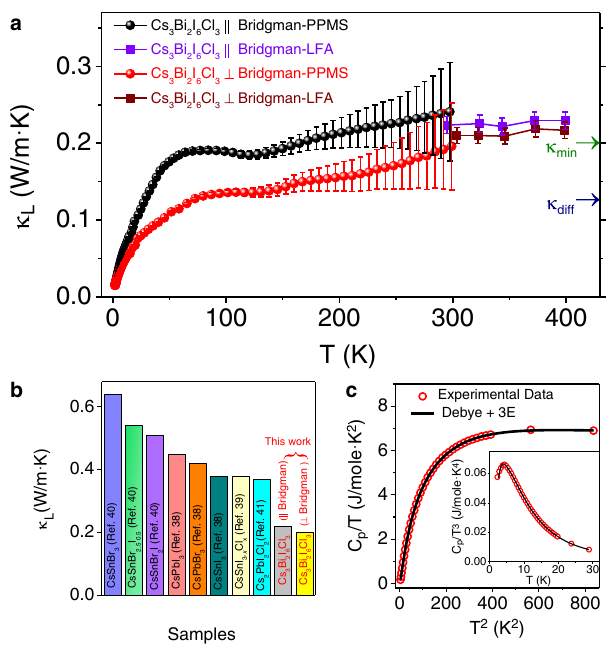
Fig. 2 | Glass-likethermalconductivityinCs 3 Bi 2 I 6 Cl 3 . a Temperature-dependent lattice thermal conductivity ( κ L ) of Cs 3 Bi 2 I 6 Cl 3 along parallel (||) and perpendicular ( ⊥ ) to the Bridgman growth directions measured using PPMS (2 – 300K) and LFA (300 – 400K). κ min is theoretical minimum value of κ L and κ diff is diffusive thermal conductivity. b Comparison of room temperature κ L of Cs 3 Bi 2 I 6 Cl 3 single crystal with other low thermal conductive all-inorganic halide perovskites 38 – 41 . c Low- temperatureC p /Tvs. T 2 plot of Cs 3 Bi 2 I 6 Cl 3 and fi t with Debye-Einsteinmodel.Inset shows C p /T 3 vs. T plot exhibiting Boson-like peak in low-temperature C p